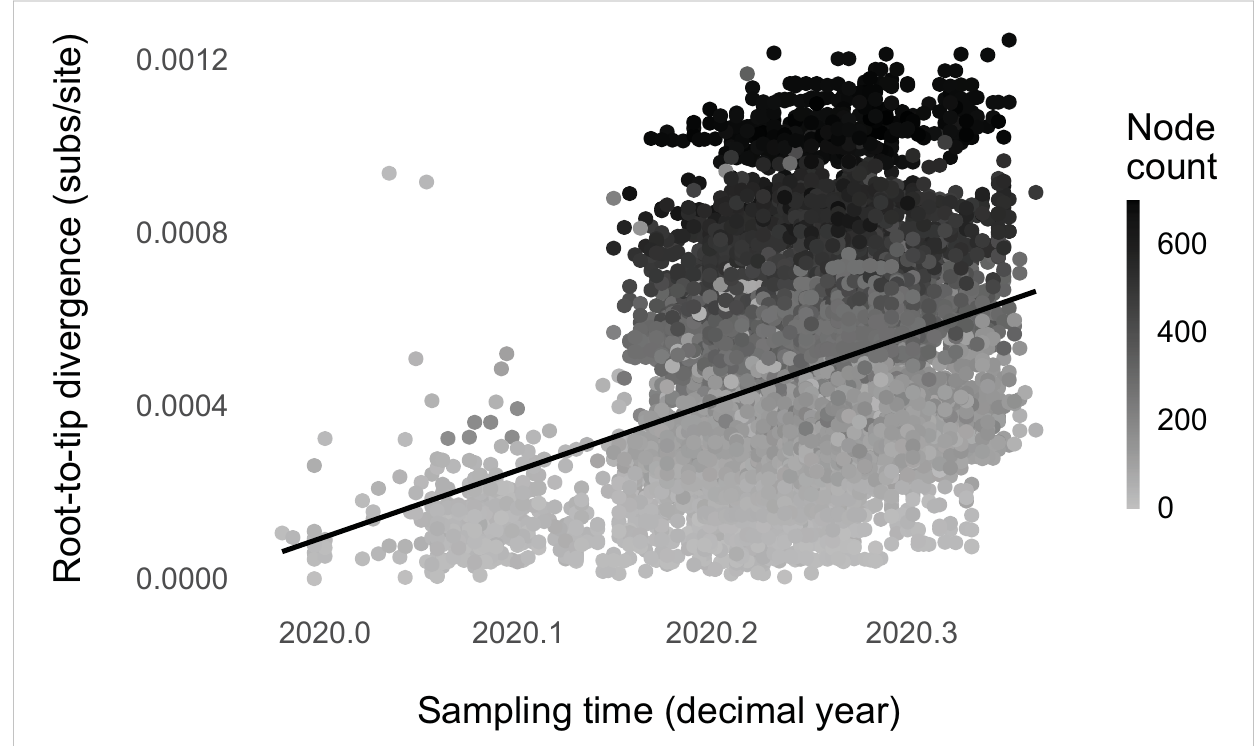
FIGURE 2 SARS-CoV-2 evolution was punctuated up to May 2020. Higher node count (net lineage-branching events) corresponds with higher root-to-tip divergence ( ^ b 2 = 2 : 2 (cid:1) 10 − 6 ), accounting for genome sampling time. We plotted the non-phylogenetic fi t line for